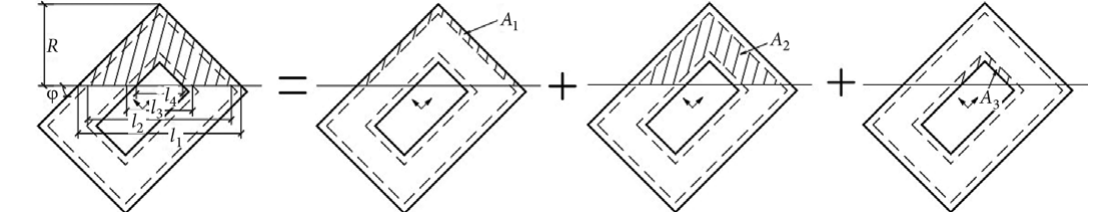
Fig. 2. Stress distribution of cross